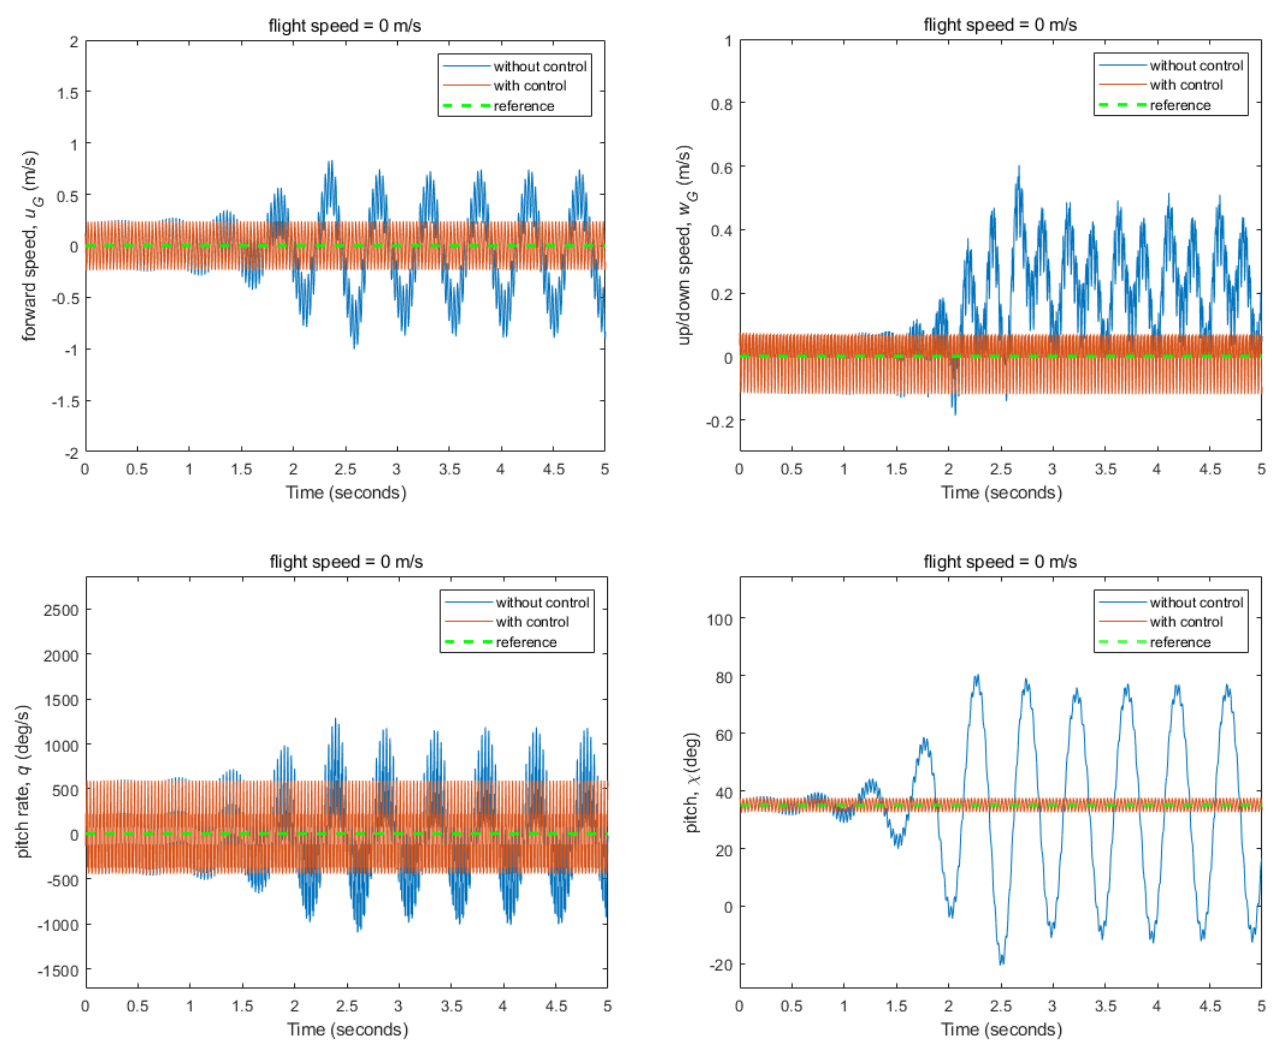
Figure 16. Flight control simulations for hovering flight control.